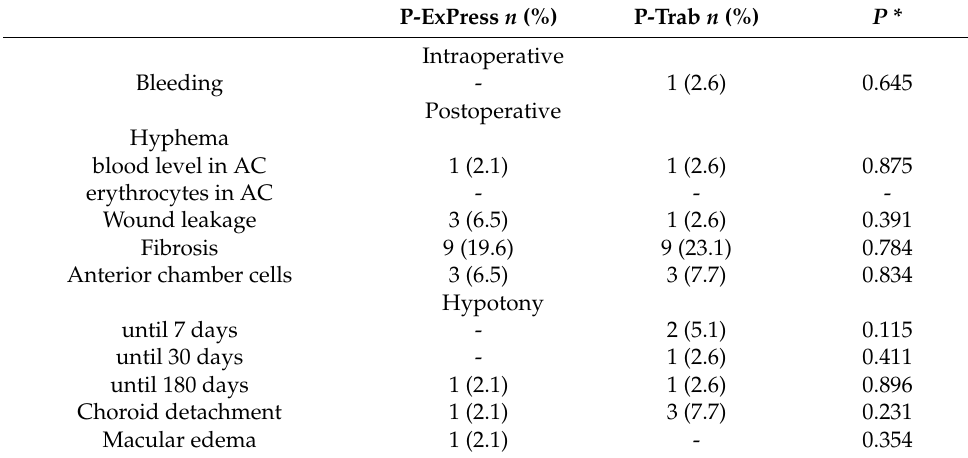
Table 5. Complications that were observed in the participants.